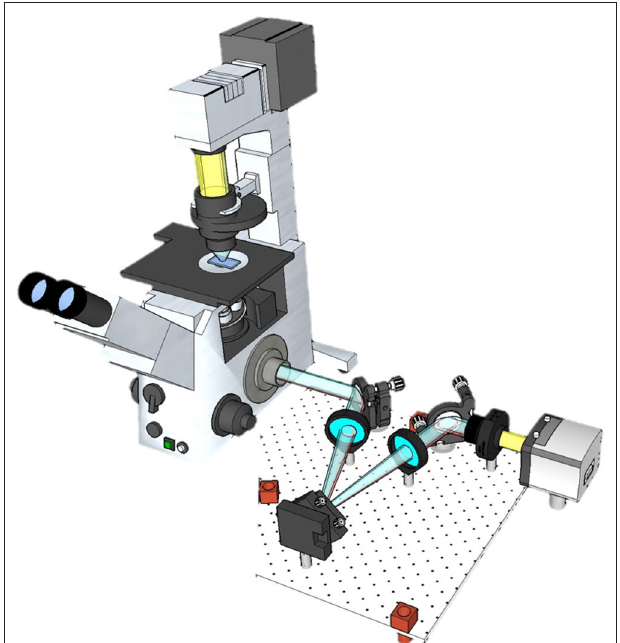
FIGURE 1 | SLIM upgrades the performance of a conventional phase contrast microscopy by attaching an external module.